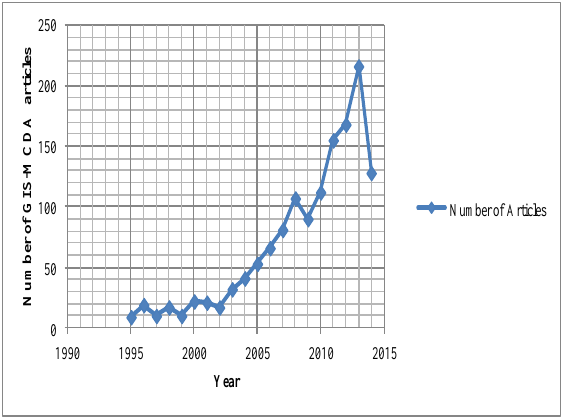
Figure 1. GIS-MCDA journal articles since